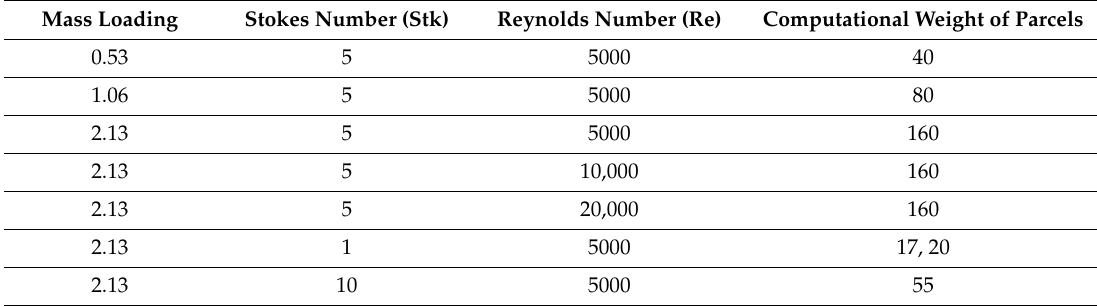
Table 1. The parameters of four di ff erent